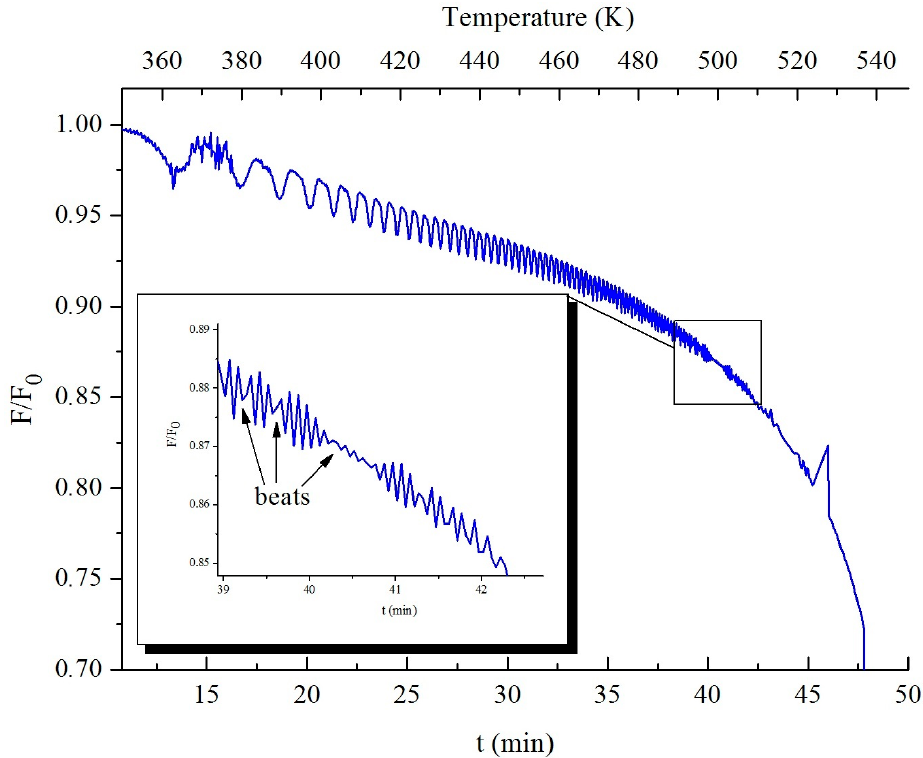
Figure 5. Experimental graph of resultant force for the Al 85 Y 8 Ni 5 Co 2 specimen. Comparison of the data in Figures 4 and 5 shows that the calculated values of reac- tion force decrease slower about experimental relation, that is only qualitative accord- ance. However, the oscillation amplitudes depicted in Figures 4 and 5 decrease with time, and the beating is also observed on the experimental curve. The oscillation frequencies in the model and experimental curve differ from frequency of the external load. It can be a result of heating and viscoelasticity of the specimen (the difference of frequency in the calculated curve distinctly relates to the presence of the hyperbolic term in Equation (6)). Herewith, for the experimental curve (Figure 5), an increase of oscillation frequency in time is typical, that is not predicted by the mentioned model equations. In the case of the cyclic load, the hardening replacing by the unloading occurs in the specimen periodical- ly, i.e., the energy of the elastic deformation with the further jump-like unloading ac- crues. This process accelerates with temperature. For this process, the difference between the model and the experiment is given by the impossibility on account of the additional functional relation between natural oscillation frequency of the specimen and tempera- ture—because of basic hypothesis about the continuity of the specimen. Frequency of the load oscillations included in the argument of the sinusoidal in the calculations (Equation (6)) is the fixed value that is set in the testing machine at the beginning of the experiment. Thus, in Figure 5, the graph of a sum of the external oscillating load and reaction force of specimen is shown taking into account the thermo-activated natural oscillations. When the application of the external load of a 3-Hz frequency coupled with addi- tional response from the specimen with frequency ω ( T ), including the reaction force of the specimen (Equation (6)), resonance occurs on the experimental curve. It is known from the theory of wave process that while superposition of two harmonic oscillations with the frequencies ω 1 and ω 2 occurs, resultant frequency